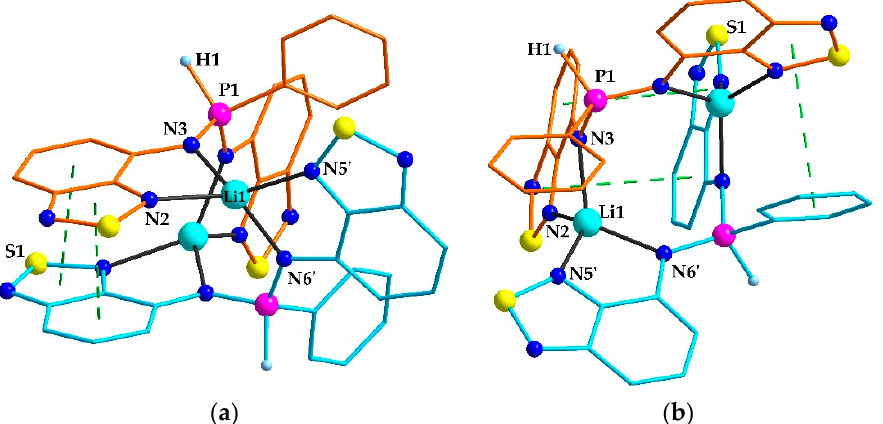
Figure 1. ( a , b ) Two projections of the structure of 2 2 · Et 2 O according to XRD. Solvate ether molecules and hydrogen atoms, except for those at the P atoms, are omitted. Different HL – ligands are coloured with orange and blue. Green dashed lines indicate π - π interactions. Selected distances (Å): N2–Li1 2.253(8); N3–Li1 2.030(9); N5–Li11 2.111(8); N6–Li11 2.065(8). Symmetry code for (‘): 1– x , y , 0.5– z .